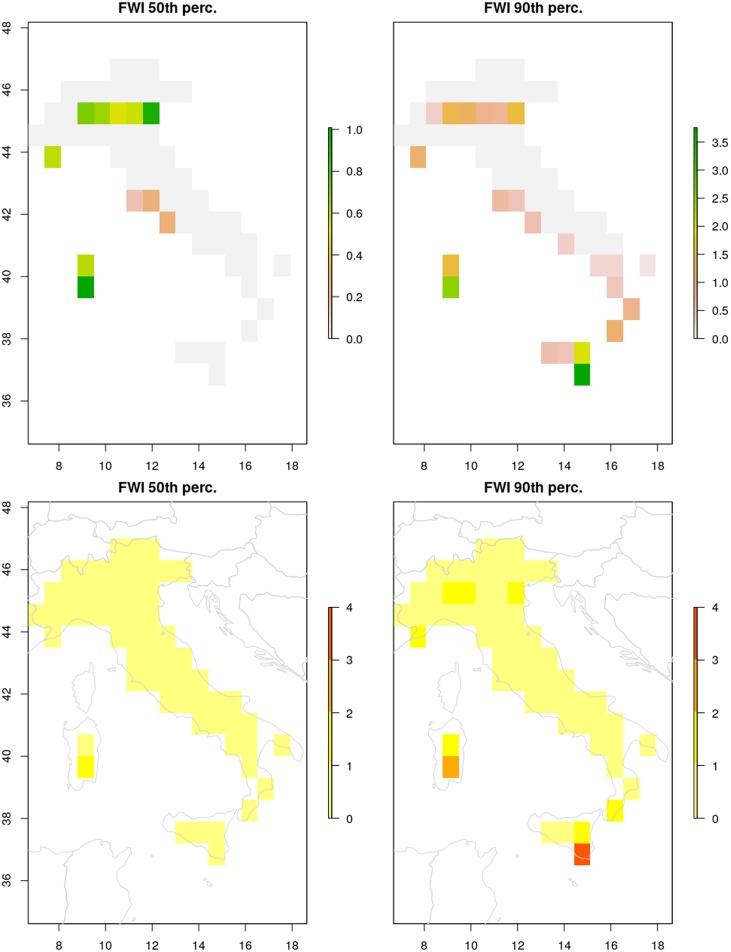
Comparison between raster plot method (top) and the caliver plot_percentile_raster function (bottom).